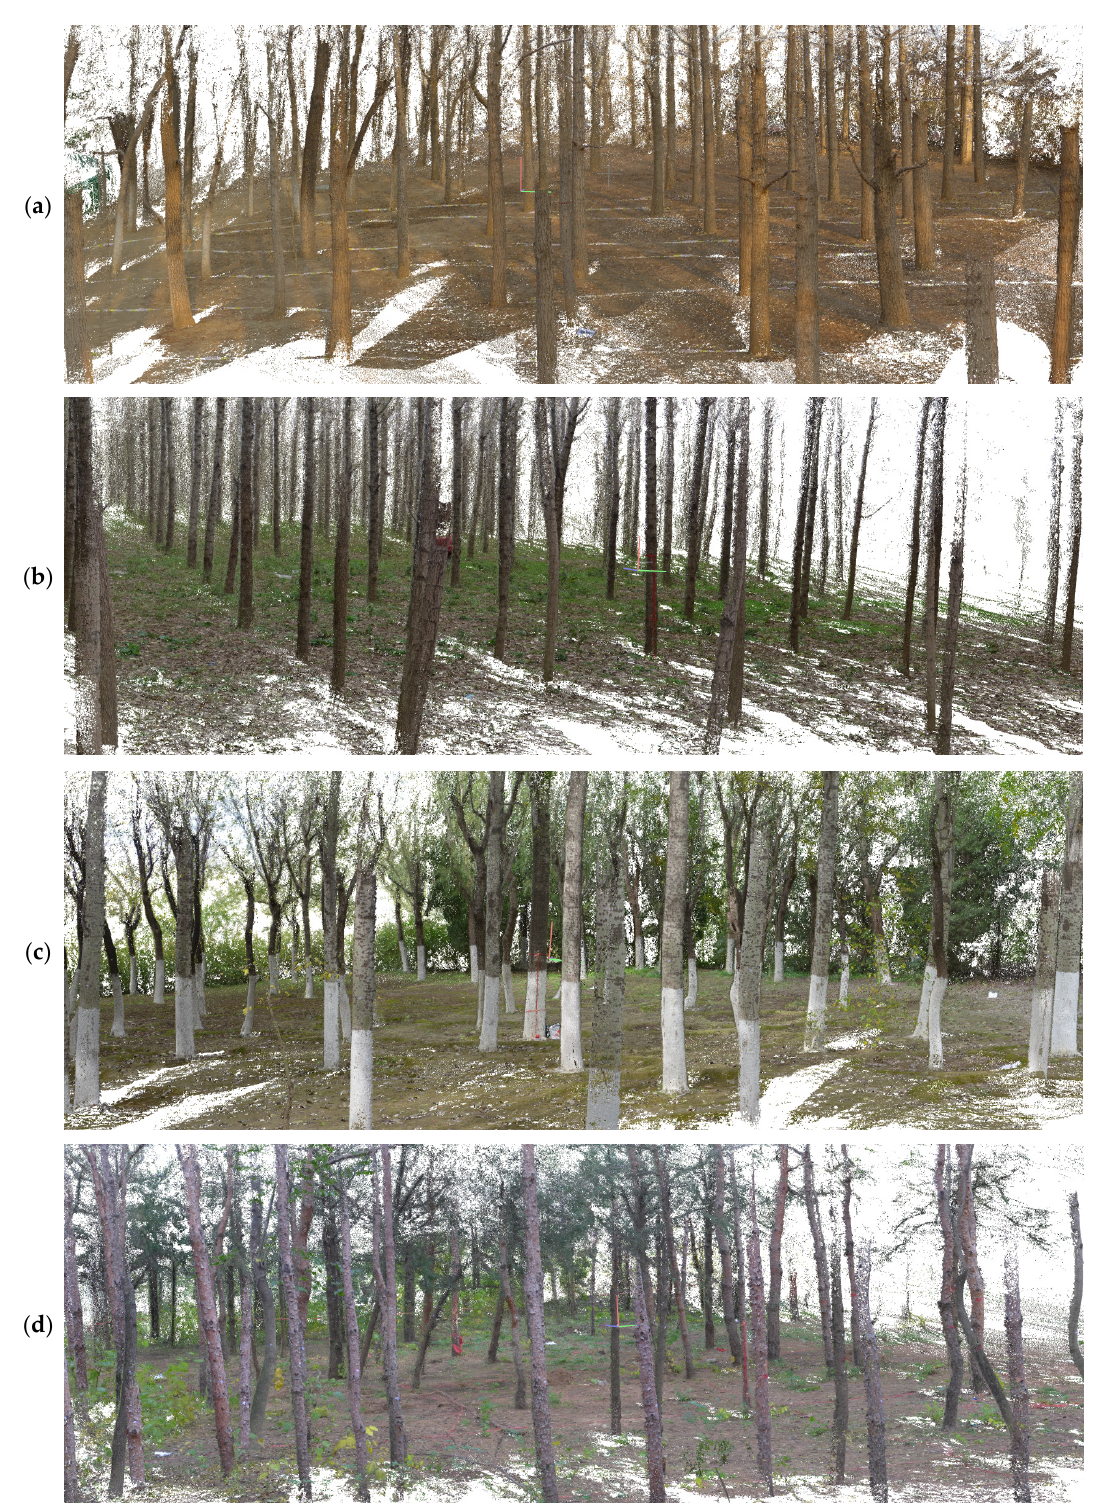
Figure 8. Dense point clouds of the four plots. ( a ) Plot 1 (Beijing); ( b ) Plot 2 (Yinan); ( c ) Plot 3 (Beijing); ( d ) Plot 4 (Beijing).